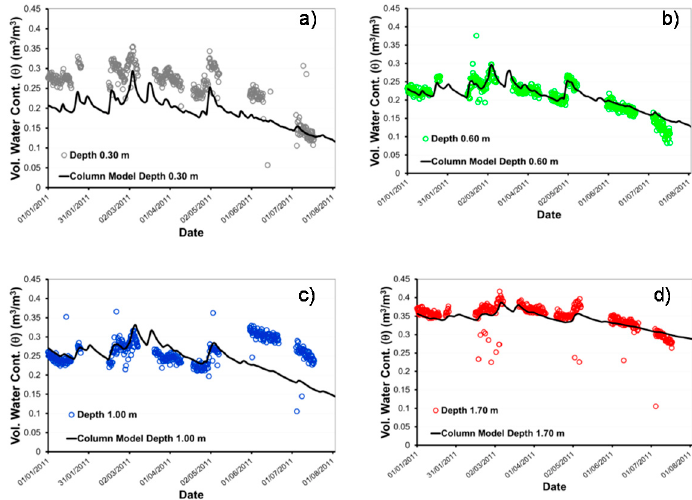
Figure 11. The Round Robin Test: comparison of computed and measured volumetric water content at a depth of ( a ) 0.30, ( b ) 0.60, ( c ) 1.00 and ( d ) 1.70 m.